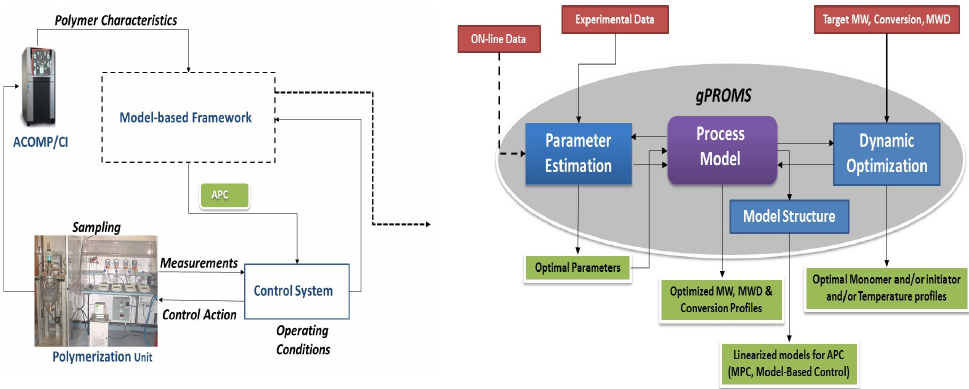
Figure 1. Schematic of the integrated simulation, estimation, optimization and feedback control of polymerization systems.